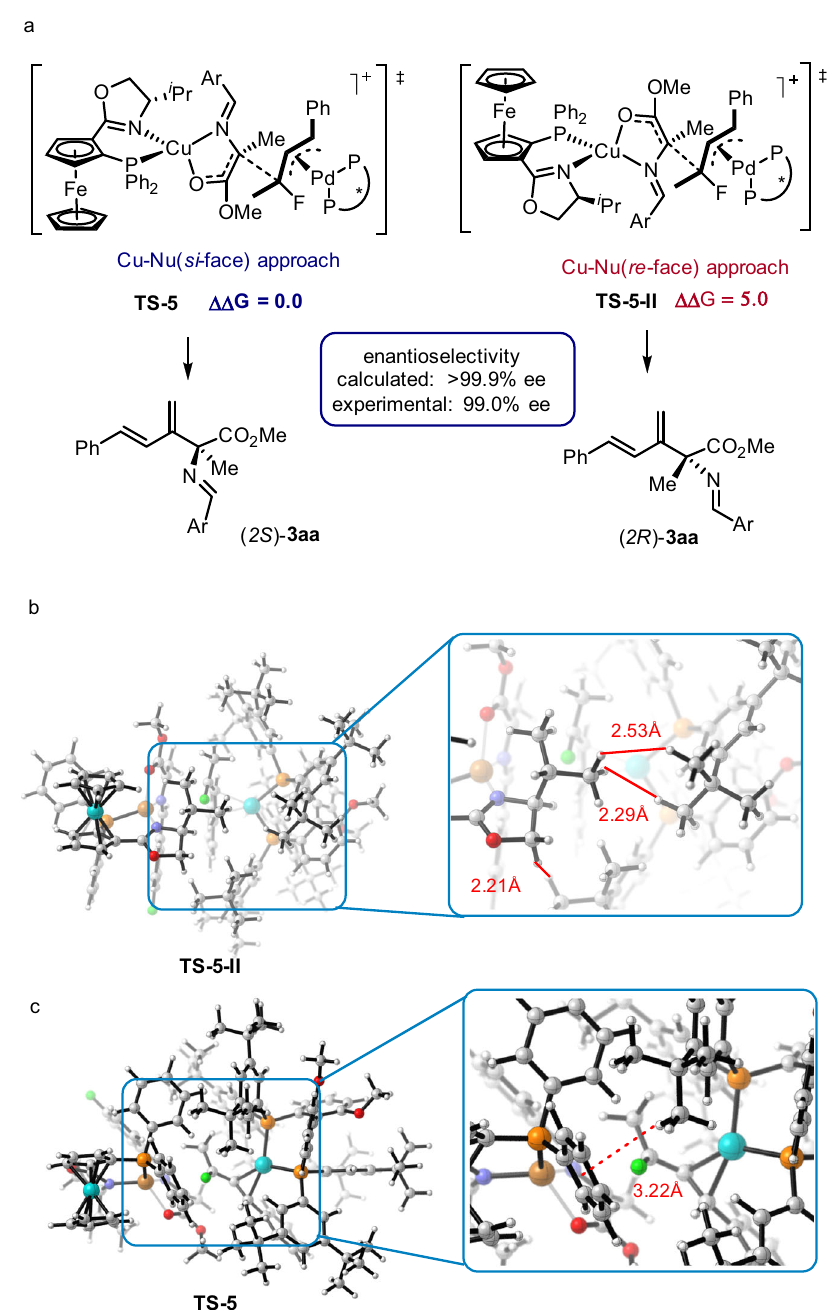
Fig. 9 Rationalization of the enantioselectivity. a Comparison of Transition states TS-5 and TS-5-II . b Steric interaction between the oxazoline ring and t -Bu group in TS-5-II . c Attractive C – H ⋯ Ar interaction in TS-5